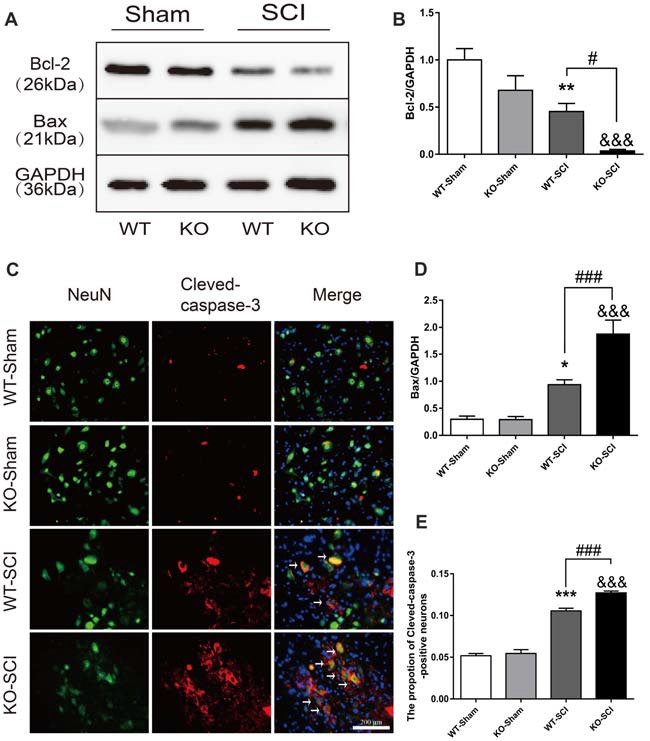
Apoe deficiency exacerbates neuronal apoptosis after SCI. (A) Representative WBs for Bcl-2 and Bax expressions and the loading control (GAPDH) in Apoe KO and WT group at 7 days post-injury. (B,D) Quantification of the expression levels of Bcl-2 and Bax. Data are expressed as mean ± SEM of three independent experiments (n = 6 per group). *p < 0.05, **p < 0.01, WT-Sham vs. WT-SCI, Bcl-2: p = 0.005, Bax: p = 0.0204, &&&p < 0.001, KO-Sham vs. KO-SCI, Bcl-2: p = 0.0008, Bax: p < 0.001, #p < 0.05, ###p < 0.001, WT-SCI vs. KO-SCI, Bcl-2: p = 0.0436, Bax: p = 0.0005, one-way ANOVA followed by Tukey’s post hoc test. (C) Representative double immunofluorescent staining for Cleaved-caspase-3-positive cells (red), NeuN (green), and DAPI (blue) in injured spinal cord of Apoe KO and WT mice at 7 days post-injury. (E) Quantification of Cleaved-caspase-3-positive cells co-labeled with NeuN to reveal apoptotic neurons. Four transverse sections were chosen at ±500 μm, ±800 μm rostral to caudal to the epicenter were obtained from each animal. Data are expressed as mean ± SEM of three independent experiments (n = 6 per group). ***p < 0.001, WT-Sham vs. WT-SCI, p < 0.0001, &&&p < 0.001, KO-Sham vs. KO-SCI, p < 0.0001, ###p < 0.001, WT-SCI vs. KO-SCI, p = 0.0003, one-way ANOVA followed by Tukey’s post hoc test. Scale bar = 100 μm.